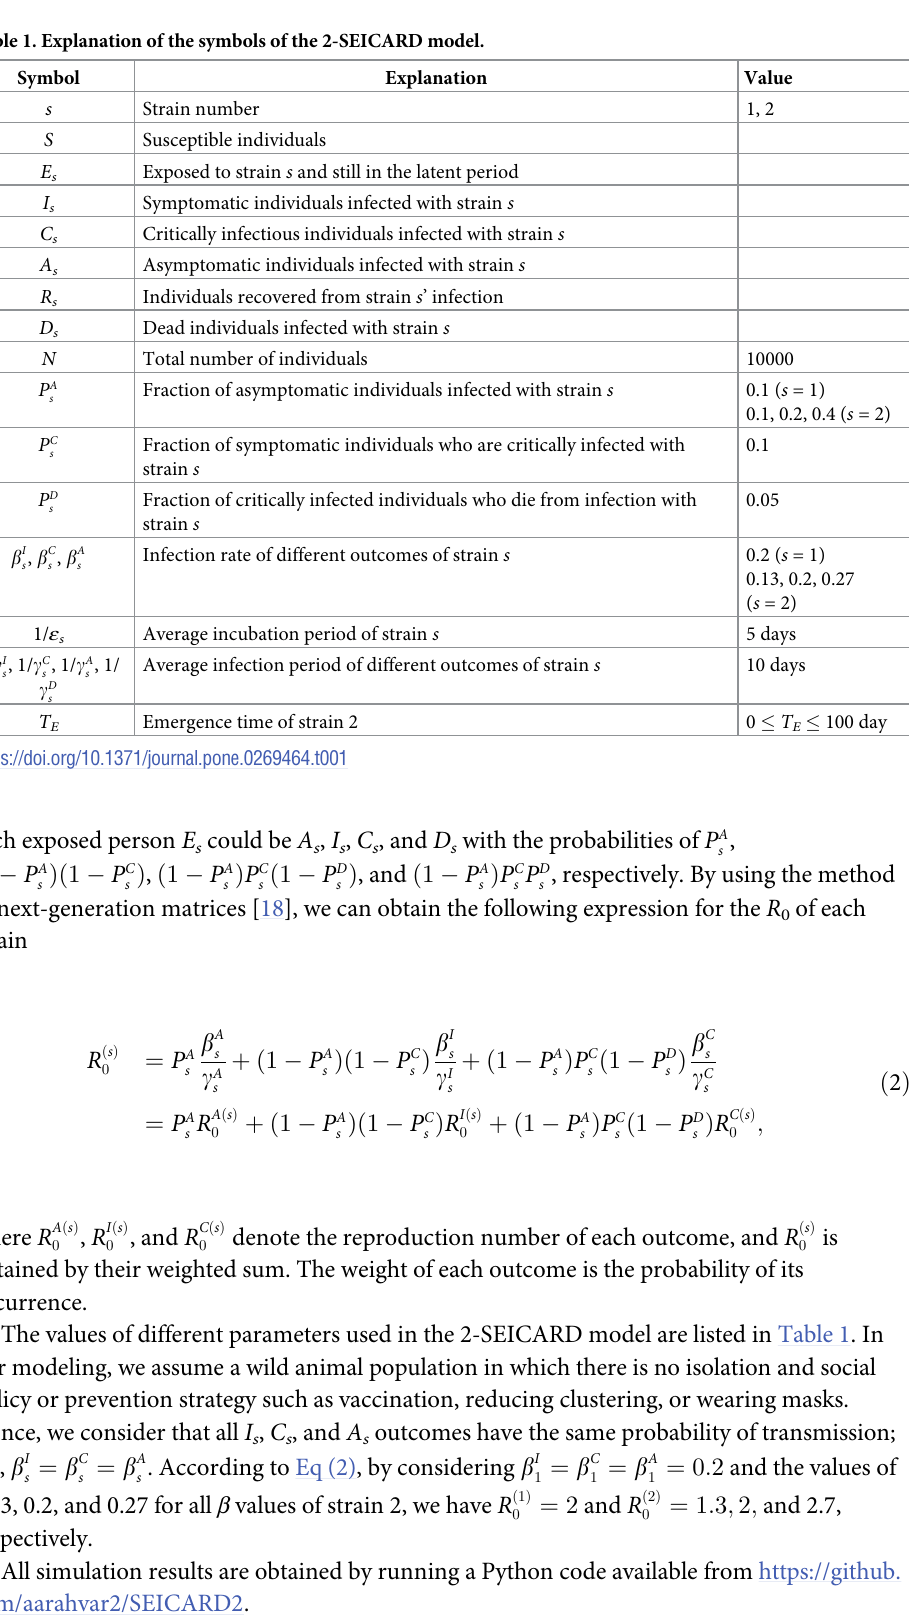
Table 1. Explanation of the symbols of the 2-SEICARD model. Symbol Explanation Value s Strain number 1, 2 S Susceptible individuals E s Exposed to strain s and still in the latent period I s Symptomatic individuals infected with strain s C s Critically infectious individuals infected with strain s A s Asymptomatic individuals infected with strain s R s Individuals recovered from strain s ’ infection D s Dead individuals infected with strain s N Total number of individuals 10000 Fraction of asymptomatic individuals infected with strain s P A s Fraction of symptomatic individuals who are critically infected with strain s Fraction of critically infected individuals who die from infection with P D s strain s Infection rate of different outcomes of strain s 0.2 ( s = 1) b I , b C , b A s s s 1/ ε Average incubation period of strain s